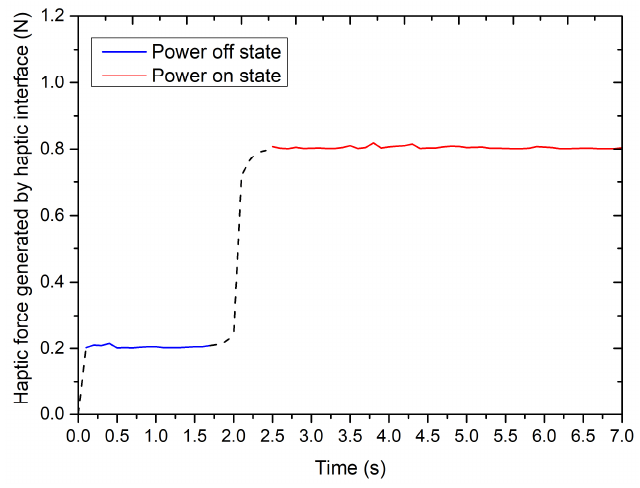
Figure 7. The experimental results for the haptic force